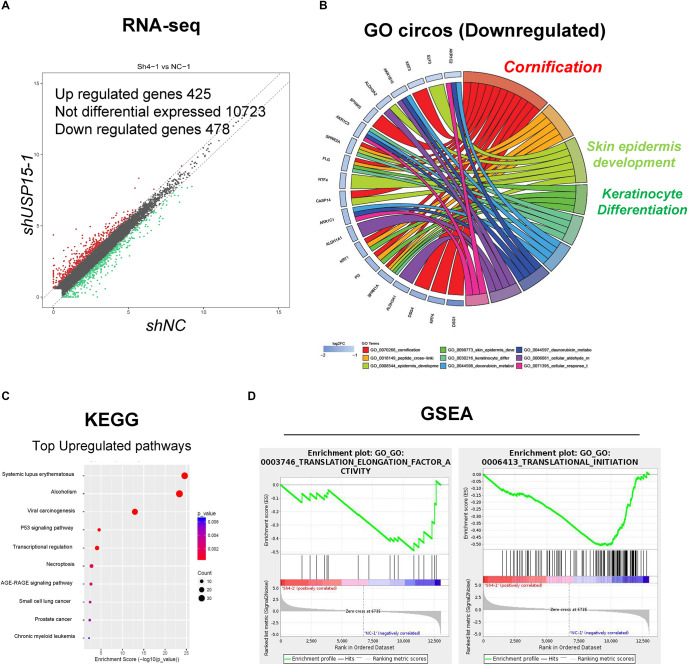
Transcriptional profiling in the USP15-silenced cells. (A) Volcano plots of differentially expressed genes. The red points denote the significantly upregulated genes, and the green points denote the significantly downregulated genes. Fold change > 1.5, p < 0.05. (B) A Gene ontology analysis and a Circos plot demonstrated that the differentially expressed genes were mainly associated with epidermal processes. The GO assay was performed in http://geneontology.org/. (C) A Kyoto Encyclopedia of Genes and Genomes assay illustrated pathways mainly involved in USP15 silencing. The KEGG assay was performed in https://www.kegg.jp/. (D) A Gene Set Enrichment analysis was performed to illustrate the translation-related pathway intensity after USP15 silencing. The GSEA assay was performed in https://www.gsea-msigdb.org/gsea/index.jsp.